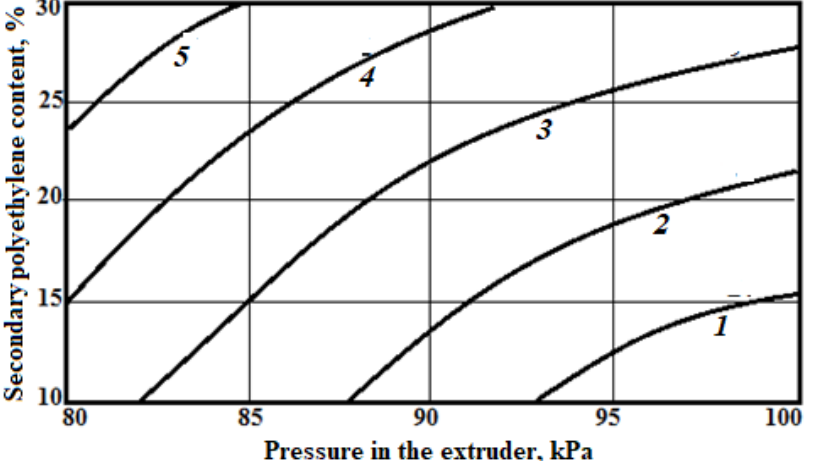
Figure 4. Dependence of the average density of polyethylene foam (Y1, kg/m 3 ) on the consumption of recycled polyethylene and the air pressure in the extruder at the optimum flame retardant consumption of 11.7 kg/m 3 and the modifier content of 6.8%. Average density values, kg/m 3 : 1–20; 2–22; 3–24; 4–26; 5–28.